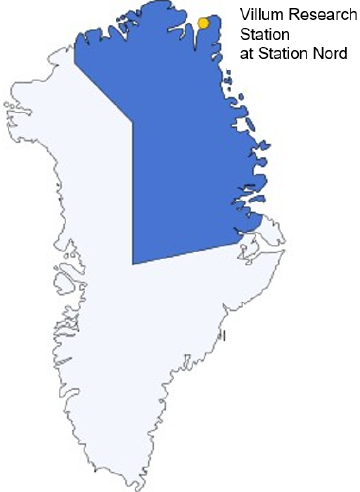
Figure 1. The position of Villum Research Station at Station Nord in northern Greenland. The blue area represents the Greenland Na- tional Park.